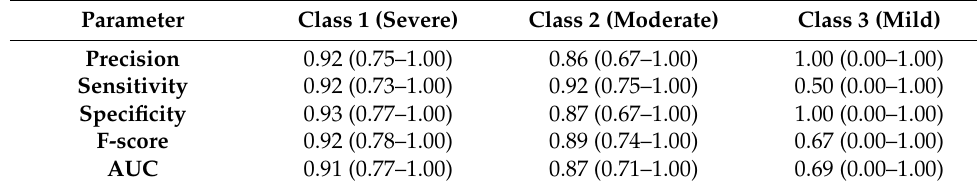
Table 7. Confusion matrix: evaluation metrics for the second AI experiment. Table 6. Most relevant features obtained by averaging and normalizing LIME predictors’ weights for the G index in the second AI experiment.